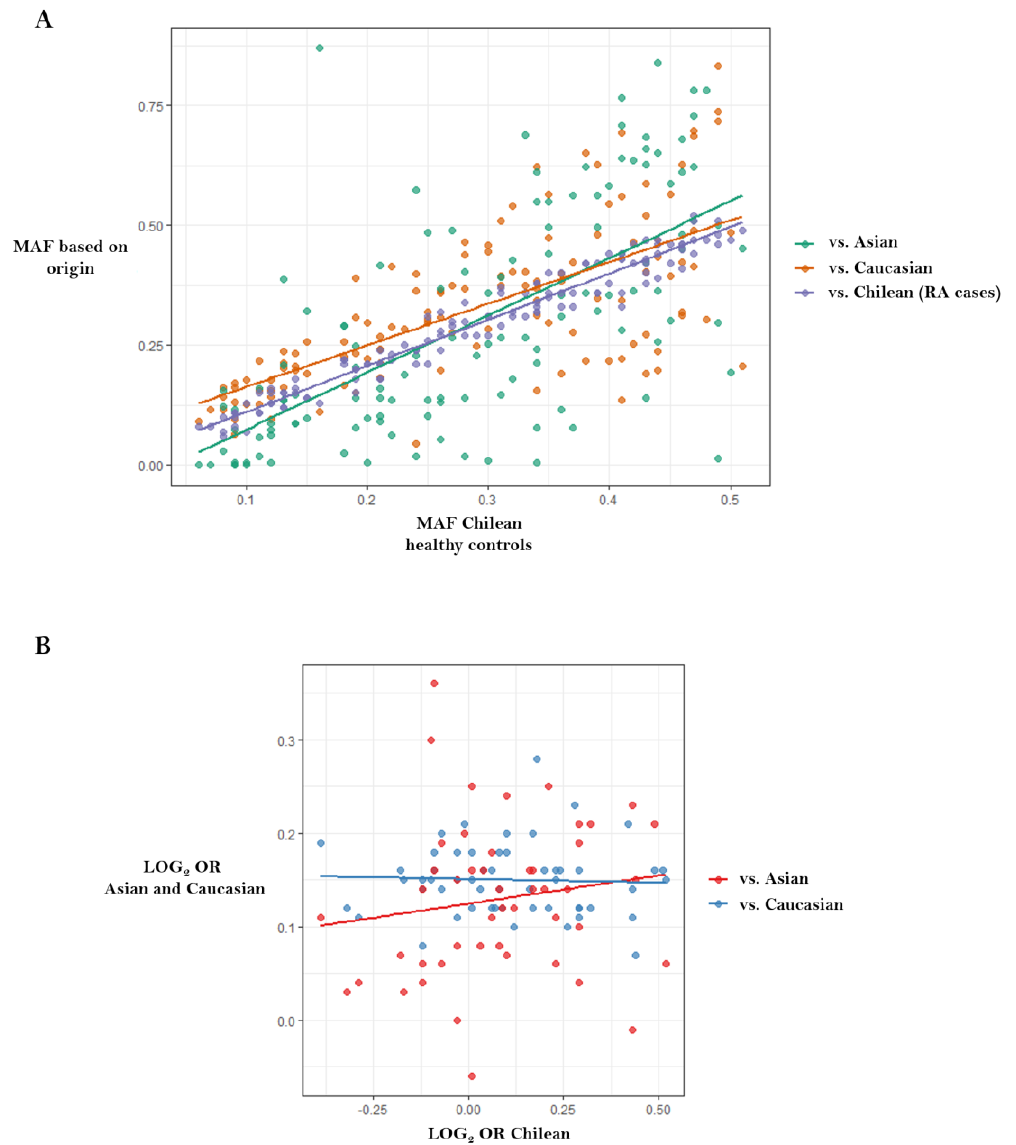
Figure 4. Correlations between data published in genome-wide association studies from Caucasians and Asians versus data reported in the Chilean population. Figure adapted from Castro-Santos et al. [46]: ( A ) Chilean population versus RA Chilean cases, Caucasian and Asian populations (http://www.1000genomes.org) (r = 0.98, r = 0.68 and r = 0.65, respectively); ( B ) Correlation between log (odds ratio) from data published in genome-wide association studies versus log (odds ratio) reported in the Chilean population. There was no correlation between data belonging to Caucasian population and Chileans (r = −0.041, p = 0.768), or between Asian populations and Chileans (r = 0.152, p = 0.302). Abbreviations: LOG, logarithm; MAF, minor allele frequency; OR, odds ratio.